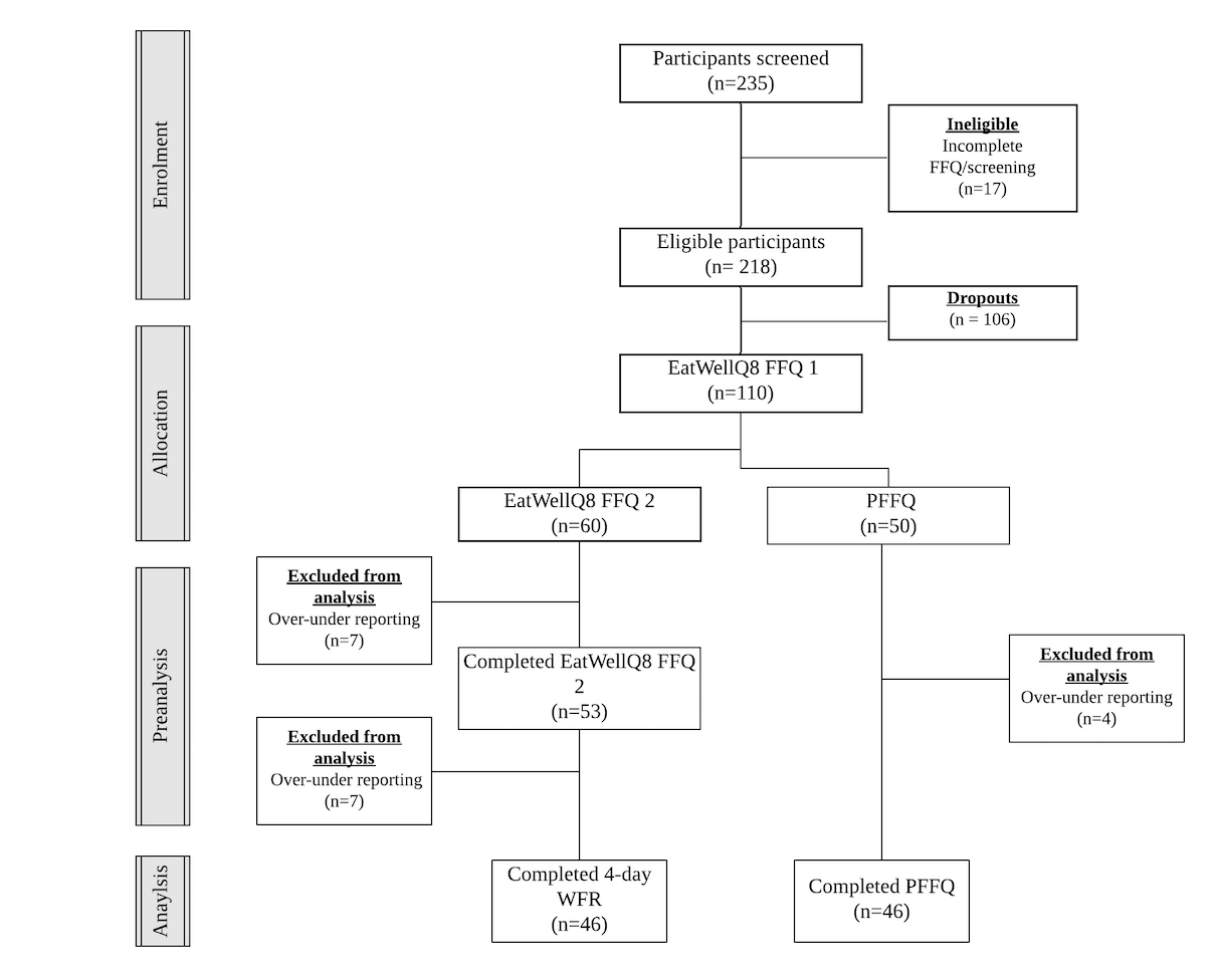
Figure 2. Participant flow during the study.